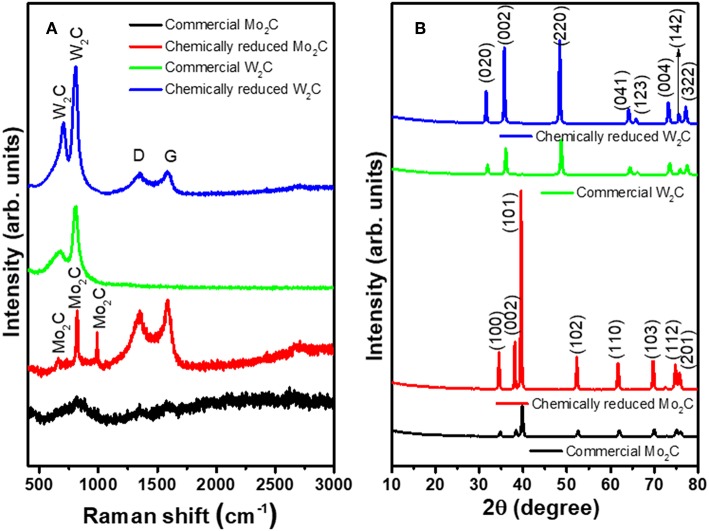
(A) XRD patterns and (B) Raman spectra of commercial Mo2C and W2C and chemically reduced Mo2C and W2C.